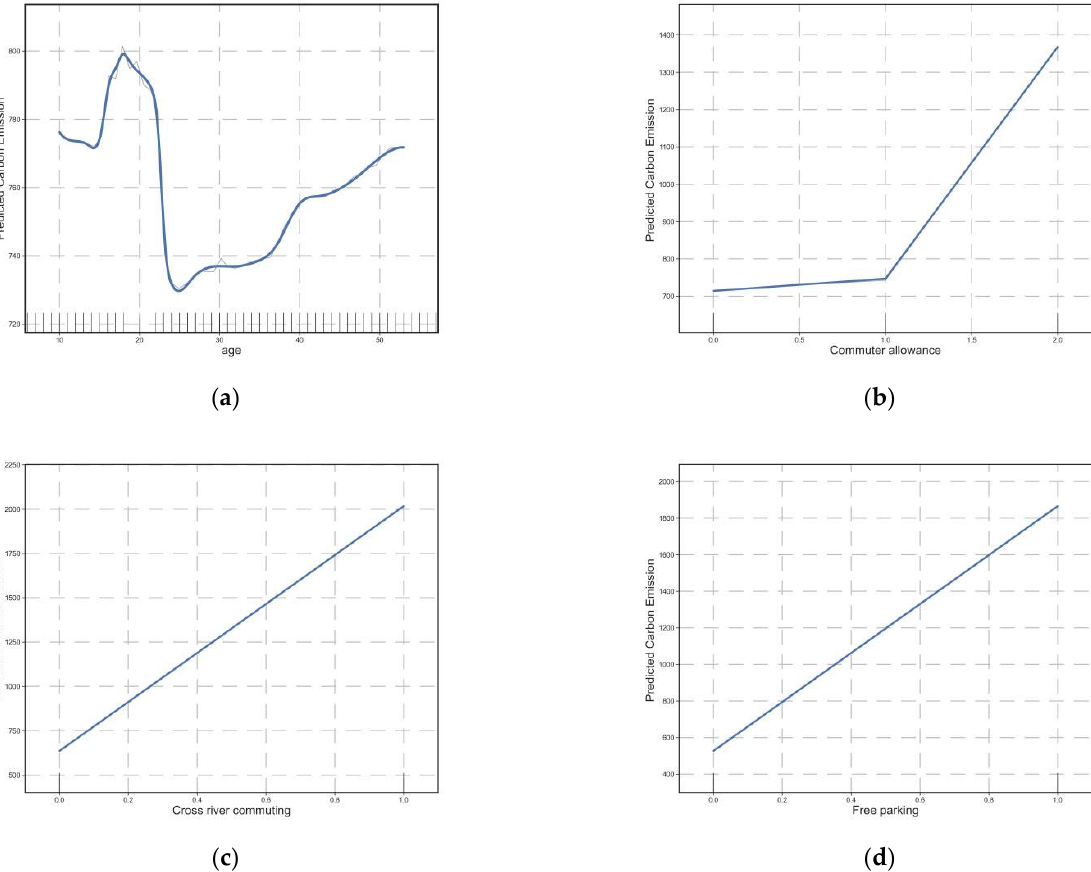
Figure 6. Influence of other dimensional elements on commuting CO 2 . ( a ) The relationship be ‐ tween age and commuting CO 2 ; ( b ) The relationship between commuter allowance and commuting CO 2 ; ( c ) The relationship between cross river commuting and commuting CO 2 ; ( d ) The relationship between free parking and commuting CO 2.